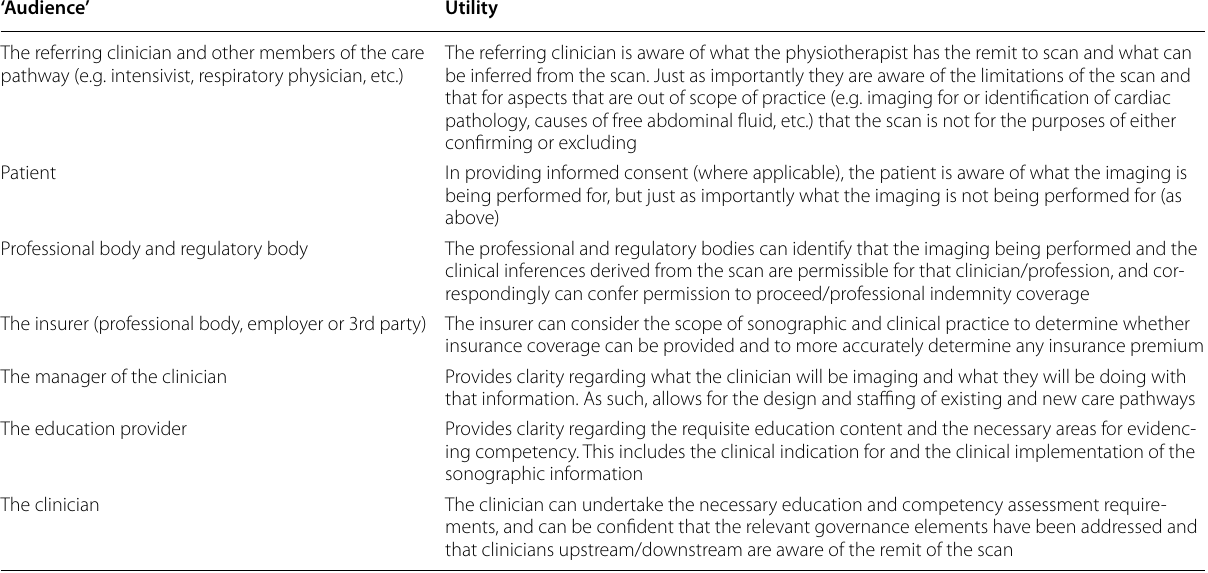
Table 3 Governance and care pathway benefits of describing scope of sonographic and clinical practice ‘Audience’